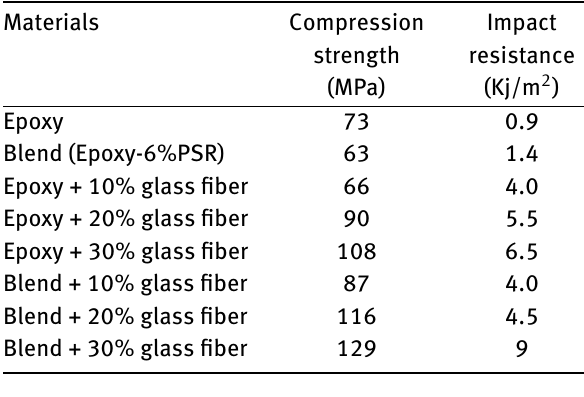
Table 1: Compressive strength and impact resistance of epoxy, blend and their composites